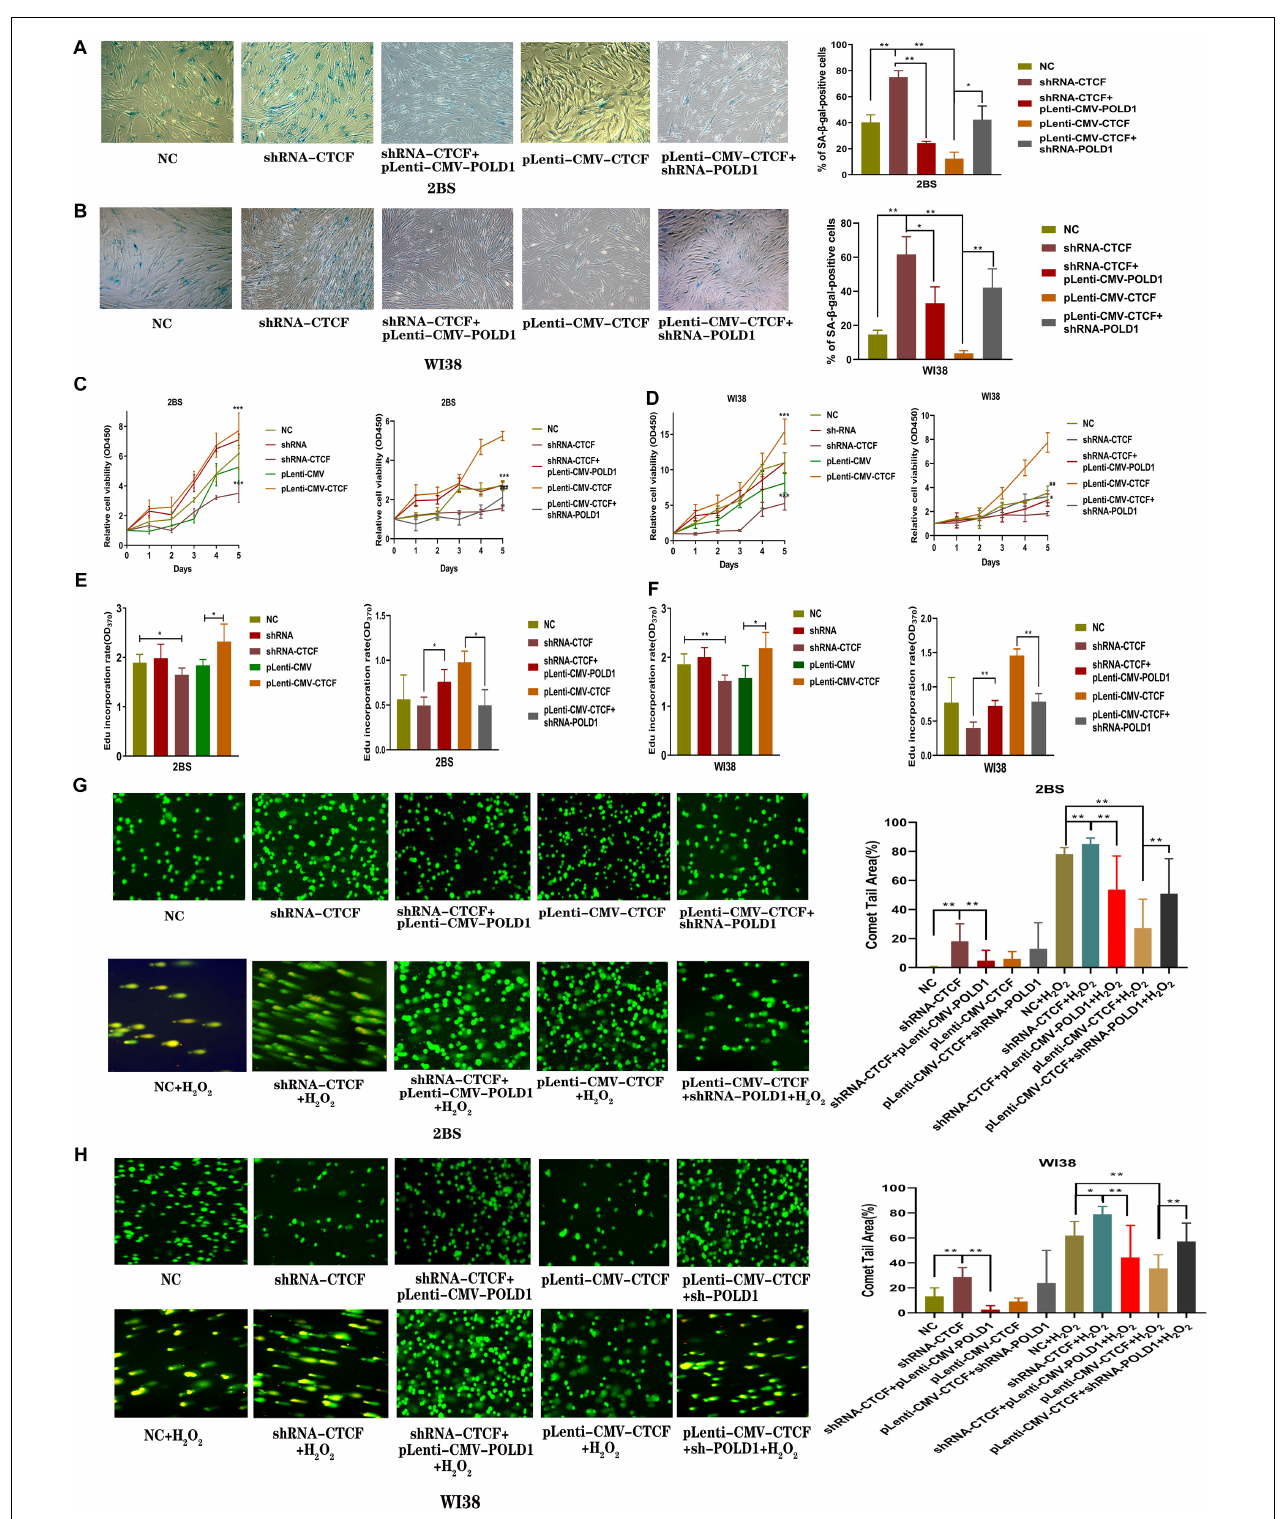
FIGURE 6 | CCCTC-binding factor (CTCF) was involved in the progression of cellular senescence, and DNA polymerase delta 1, catalytic subunit (POLD1) rescued the effect of the downregulated CTCF on aging. (A,B) Senescence-associated β -galactosidase (SA- β -gal) staining of 2BS (A) and WI38 cells (B) transfected with the